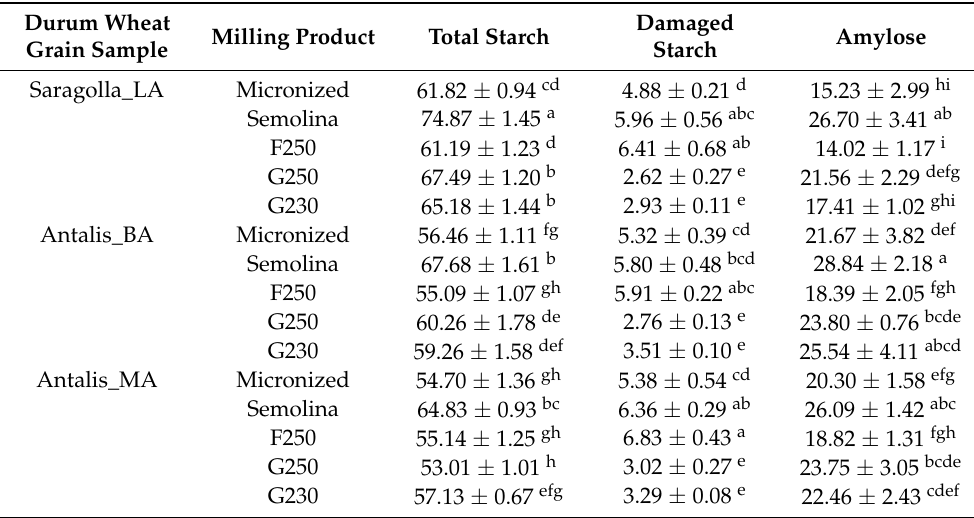
Table 3. Total starch, damaged starch and amylose (% d.m.) of five milling products: micronized sample, air-classified fractions (F250, G250, G230) and semolina obtained from three durum grain samples (Saragolla_LA, Antalis_BA, Antalis_MA). Different letters indicate statistically significant differences ( p < 0.05, n = 3) within each milling product ( n =